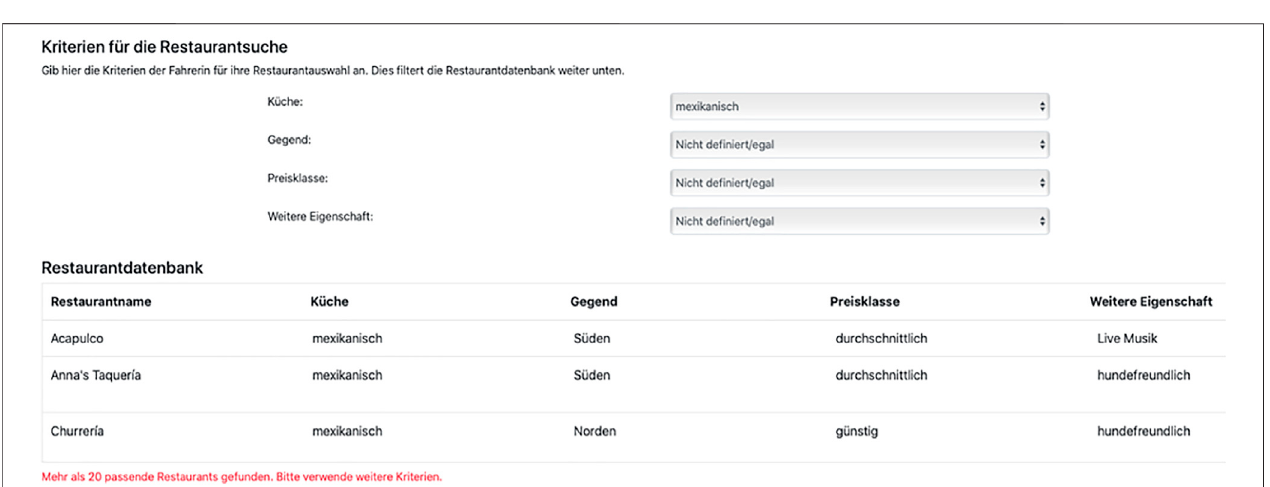
FIGURE 3 | Restaurant database which the assistant participants could query to fi nd venues matching the user ’ s request.